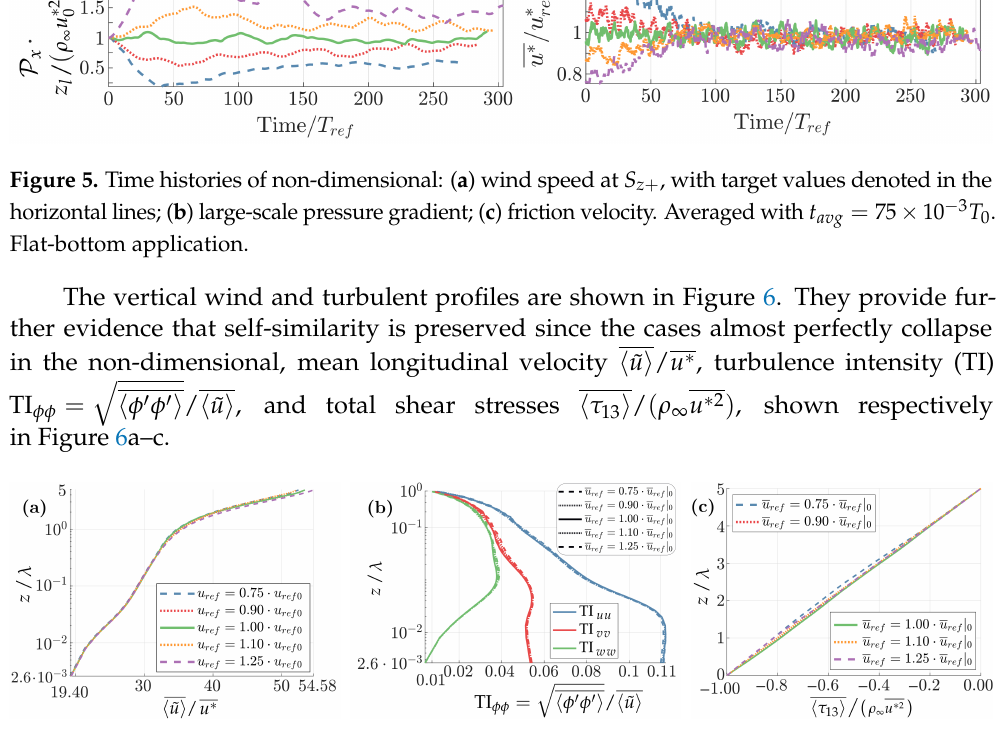
Figure 6. Height-dependent wind and turbulence profiles averaged with t avg = 75 T 0 . Flat-bottom ap- plication. ( a ) longitudinal velocity; ( b ) turbulence intensity (TI); ( c ) total shear stress. The normalizing friction velocity is resolved, as obtained from Equation